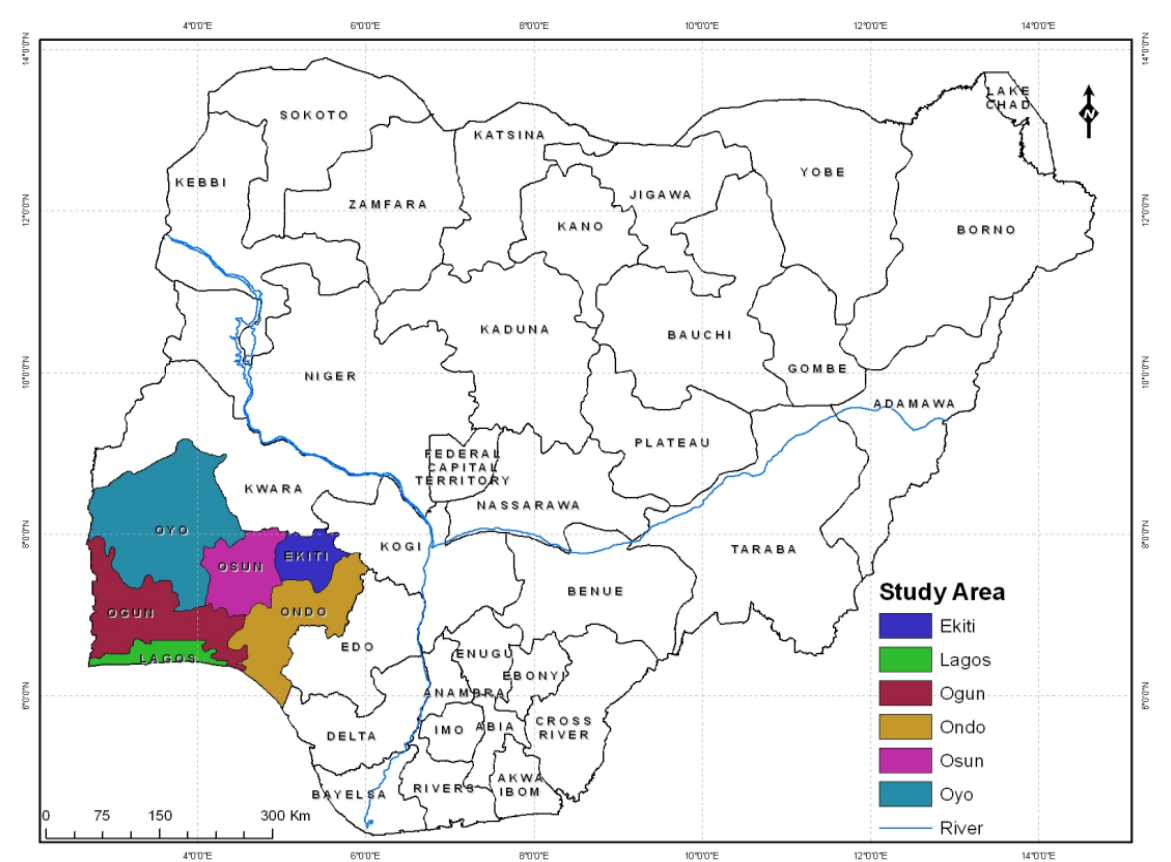
Figure 1. South West Map indicated on Map of Nigeria. Source: